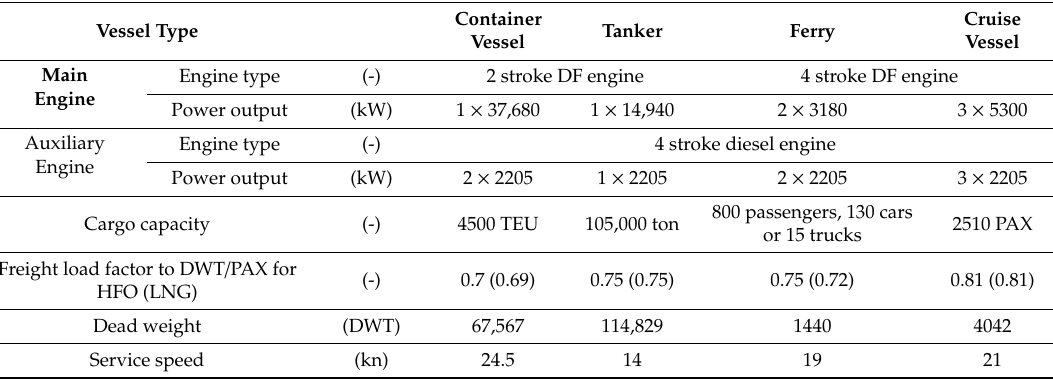
Table 1. Vessel specifications based on DNV GL inhouse data.